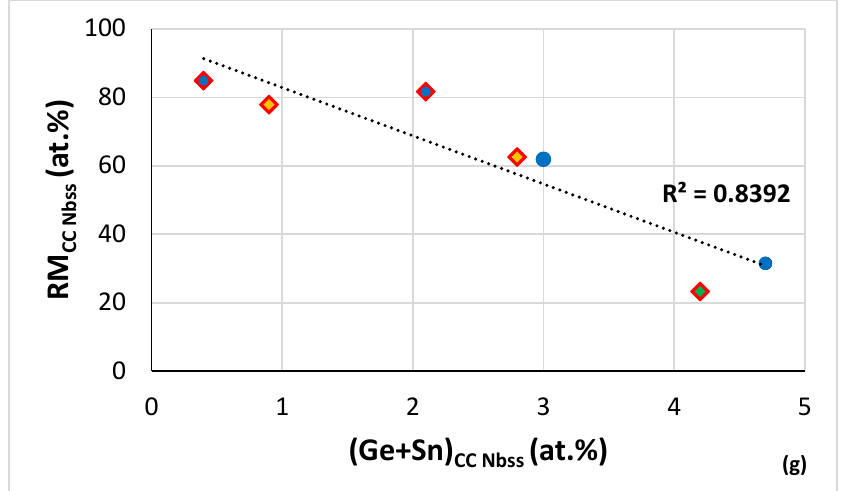
Figure 9. ( a – g ) data for the AC alloys JZ3, JZ3+, OHS1 and the HT alloys JZ3+, JZ4, JZ5 with simultaneous addition of Ge+Sn. Concentration of (Ge+Sn) versus ( a ) Ti, ( b ) Cr, ( c ) Al, ( d ) Al+Cr in CC Nb ss . ( e ) Al+Cr concentration versus Nb/Ti ratio, ( f ) Nb/Ti ratio versus (Ge+Sn) concentration and ( g ) total RM (=Nb + Mo + Ta + W) concentration versus (Ge+Sn) concentration in CC Nb ss . R 2 values are for the linear fit of all data in each part. Solid solution in RM(Nb)IC/RCCA alloy indicated with diamond and the green colour is for the alloy OHS1. In ( g ) blue colour for alloys where RM = Nb + Ta + W, yellow for RM = Nb + Mo + W and green for RM = Nb, i.e., for the alloy OHS1. See Appendix A for nominal alloy compositions and references.